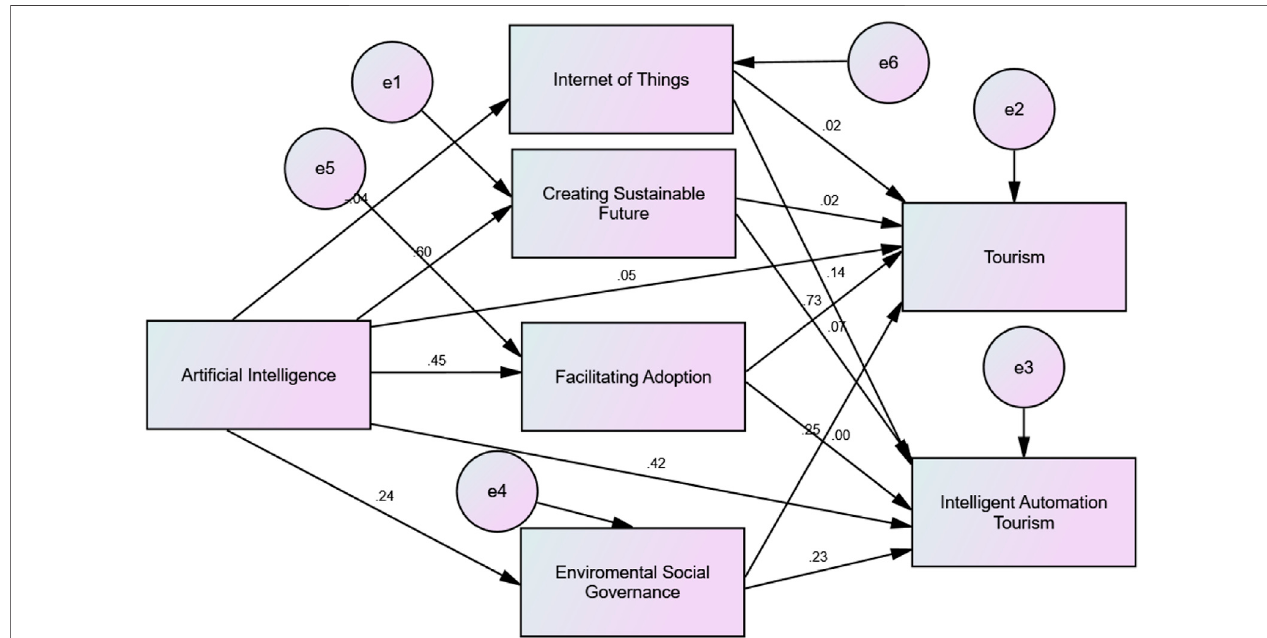
FIGURE 4 | Empirical results from a complex multivariate initial model representation standardized regression coef fi cient for intelligent automation in tourism ( N = 402). Note: a complex multivariate model of fi ve endogenous constructs and two exogenous indicators. Completely standardized maximum likelihood parameter estimate for intelligent automation in tourism among tourists and